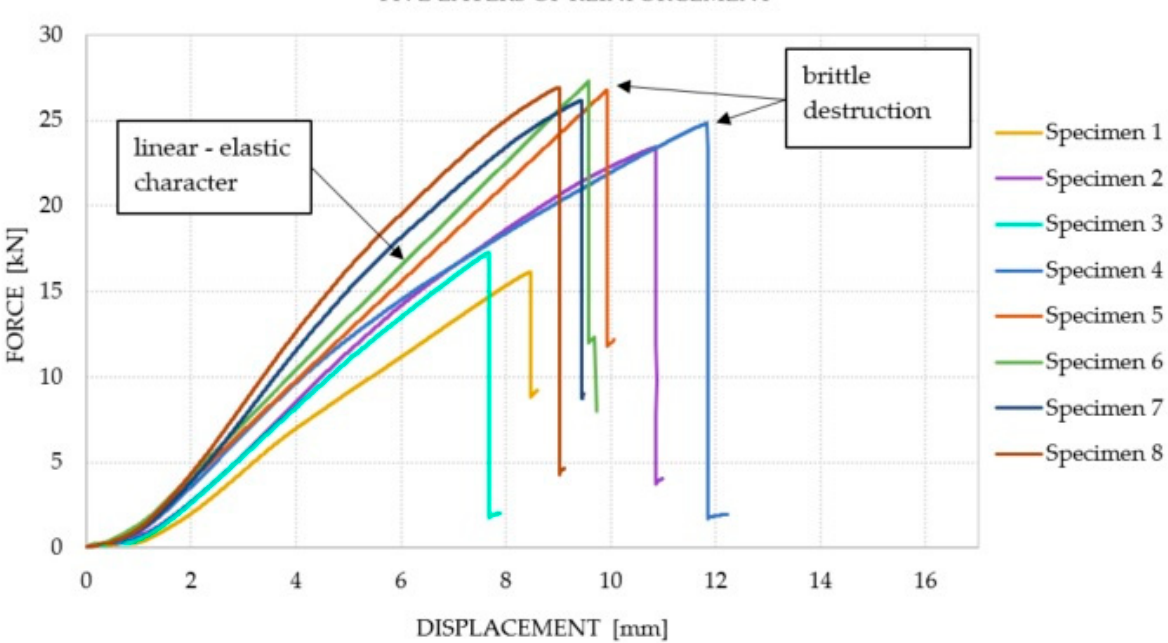
Figure 10. Force–displacement chart for the beams with five layers of reinforcement.